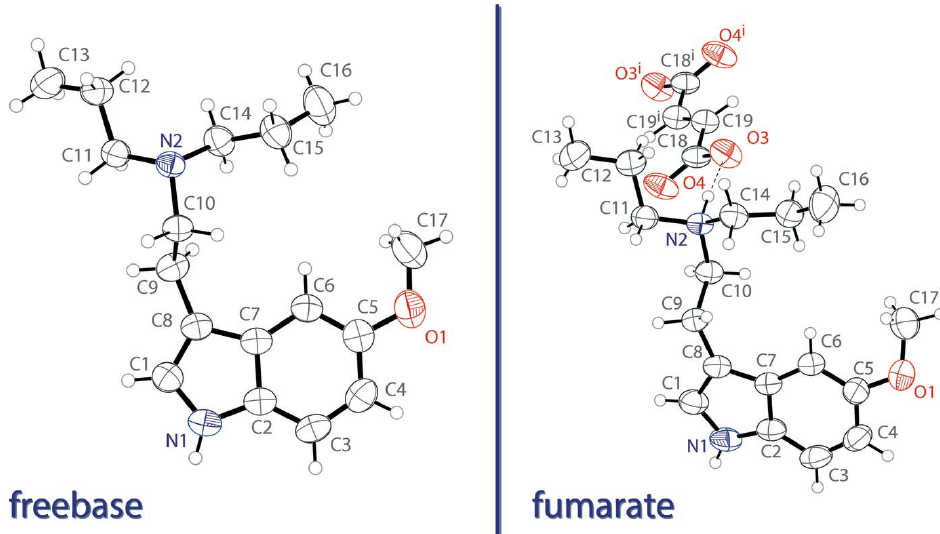
Figure 1 The molecular structures of 5-MeO-DPT freebase (left) and 5-MeO-DPT fumarate (right), showing the atomic labeling. Displacement ellipsoids are drawn at the 50% probability level. Hydrogen bonds are shown as dashed lines. Symmetry code: (i) 1 (cid:3) x , 2 (cid:3) y , 2 (cid:3) z